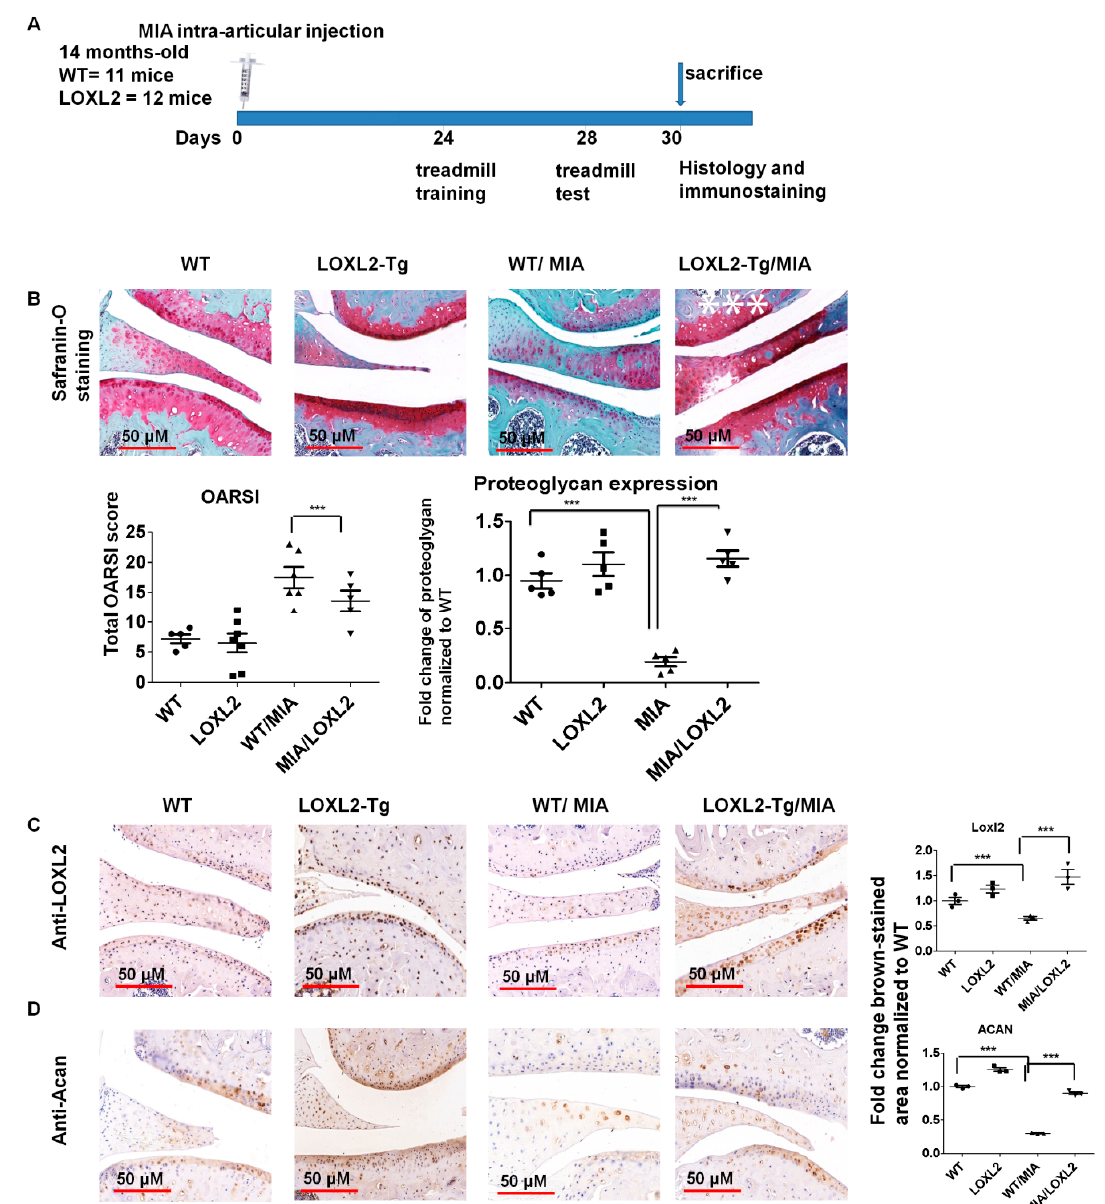
Figure 5. LOXL2 overexpression in transgenic mice protects against MIA-induced OA-related catabolic changes in knee joint articular cartilage. ( A ) Scheme of LOXL2 mice MIA injection groups and its functional analysis; ( B ) Safranin-O staining in the indicated WT and LOXL2 transgenic groups, its quantification and OARSI scoring. Immunostaining and quantification of ( C ) LOXL2 and ( D ) Acan in MIA injected LOXL2 overexpressing or WT mice. The fold change di ff erences in immunostaining for LOXL2 and Acan expression in WT (dot), LOXL2 (square), WT / MIA (triangle) and MIA / LOXL2 (inverted triangles) are shown in adjacent figures. The statistically significant di ff erences in immunostaining were evaluated by one-way ANOVA with Bonferroni correction (*** p < 0.001; ANOVA).